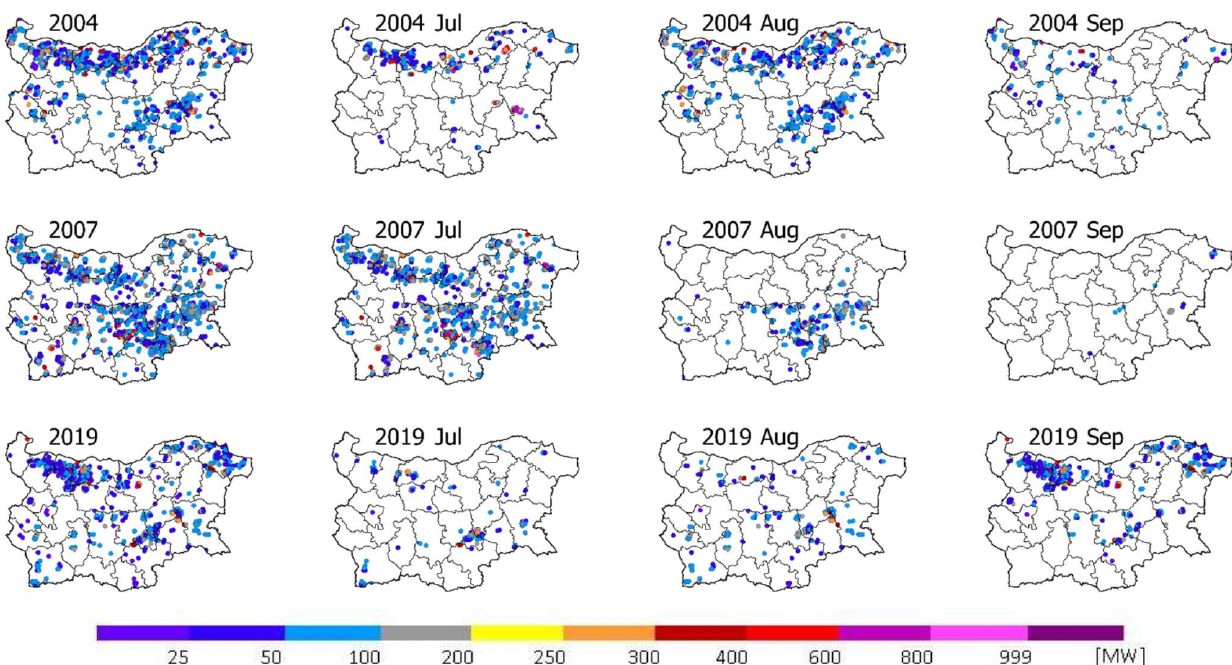
Figure 3. Maps of the spatial–temporal (monthly/annual) distribution of fire activity over Bulgaria. Color-coded severity of biomass burning according LSASAF FRP-Pixel (MW) is indicated.